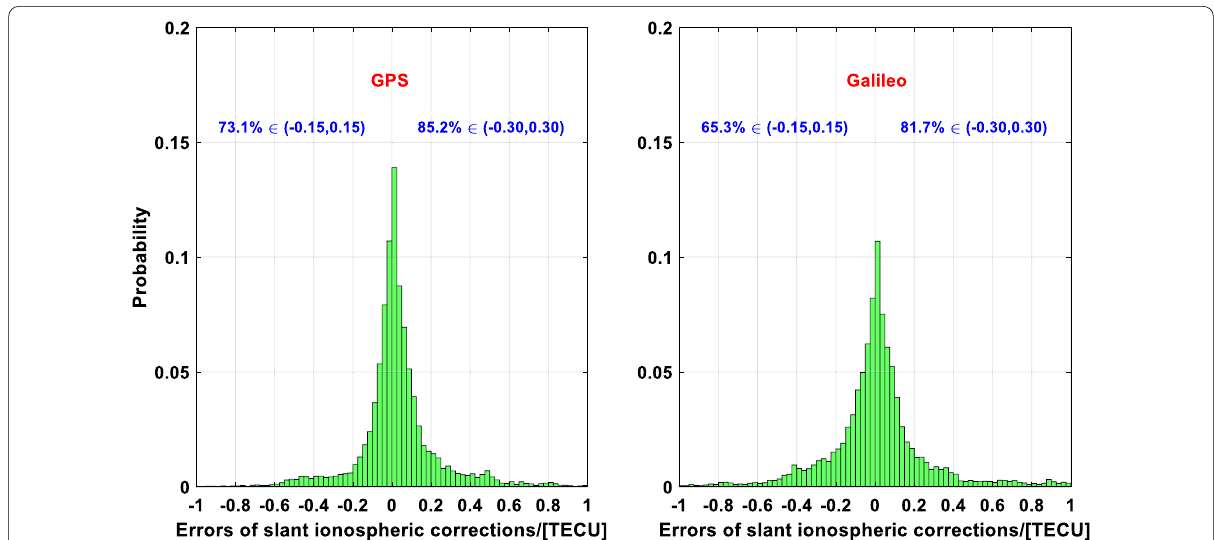
Fig. 7 Error distribution of the SD slant ionospheric delays in different satellite systems (left panel: GPS; right panel: